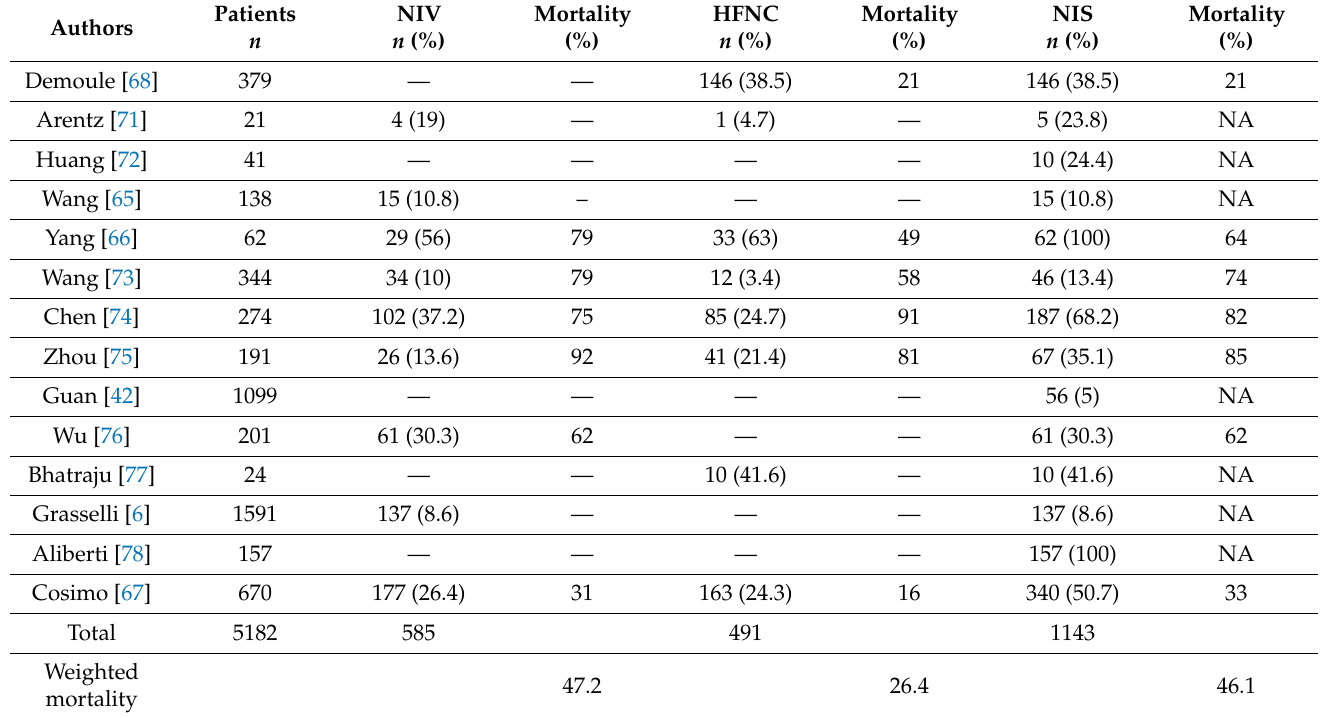
Table 1. Use of non-invasive respiratory support and related mortality among patients with